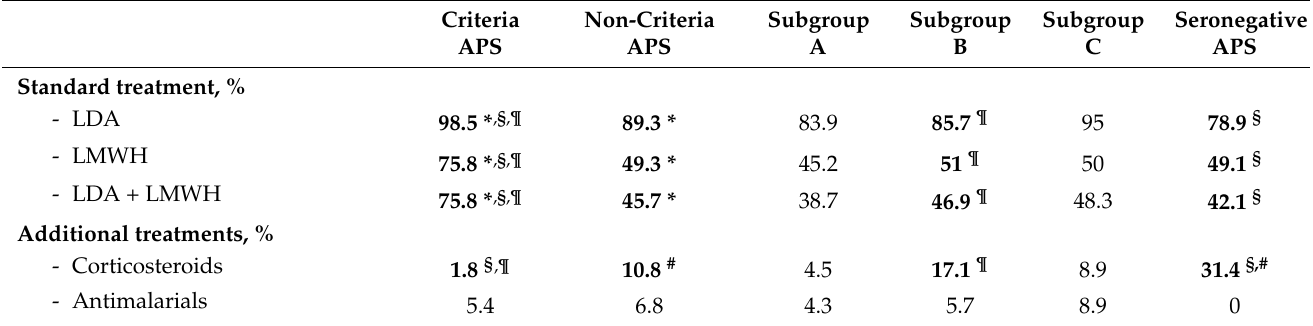
Table 5. Main treatments in the different study